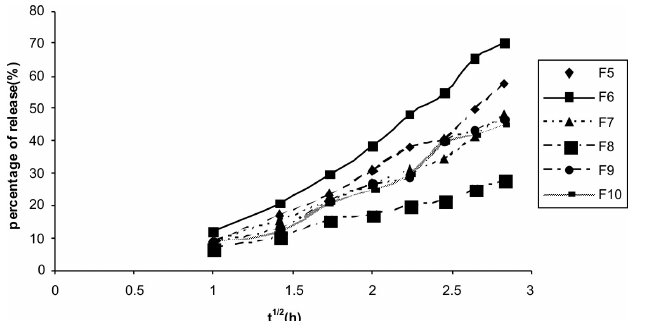
FIGURE 2 - Plots of percentage release versus t 1/2